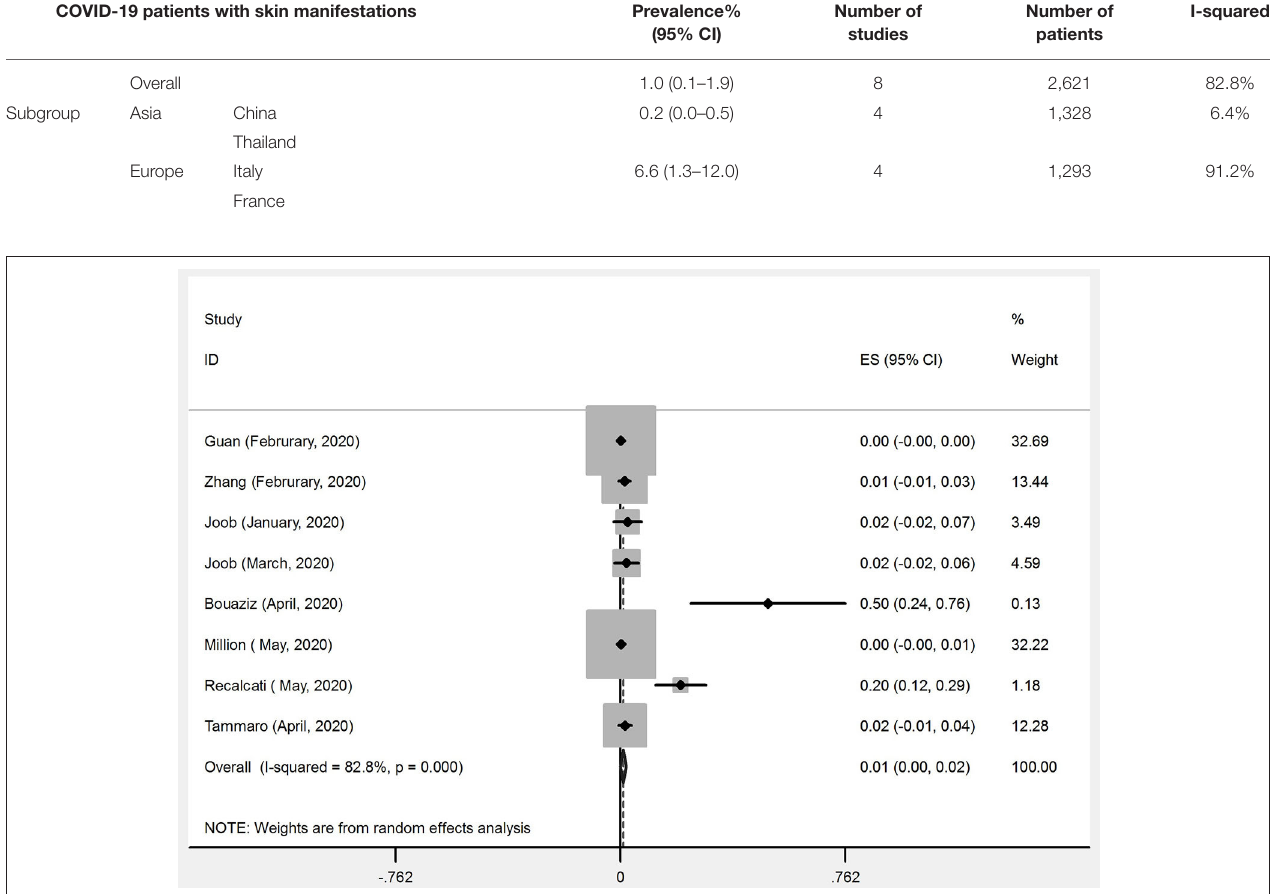
of the intervention effect estimates from individual studies against a measure of study size) and Figure 4 (called a galbraith plot for displaying several estimates of the same quantity that have different standard errors). The numbers and types of skin manifestations among COVID-19 patients were as follow: erythematous rash (15/2,621), urticaria (7/2,621), exanthema (4/2,621), chickenpox like-vesicles (3/2,621), petechia, purpura, chilblain like-lesion and herpetiform lesion (each 2/2,621), and livedo and eruptive cherry angioma (each 1/2,621). Erythematous rash and urticaria were the most skin manifestations among patients with